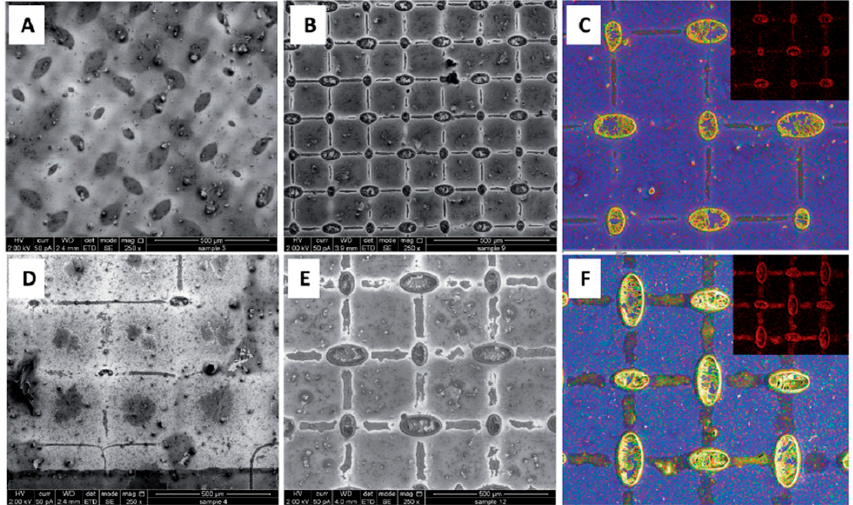
Figure 4. HRSEM images for 0.2 M PbI 2 grid obtained using: ( A ) 85 µ m size of mesh before annealing. ( B ) With annealing, mesh size. ( C ) PbI 2 chemical mapping (A grid developed during annealing using a mesh size of 85 µ m is coloured yellow for the Pb metal and red for the inset I). ( D ) 240 µ m without annealing mesh. ( E ) 240 µ m mesh size with annealing ( F ) PbI 2 chemical mapping (A grid